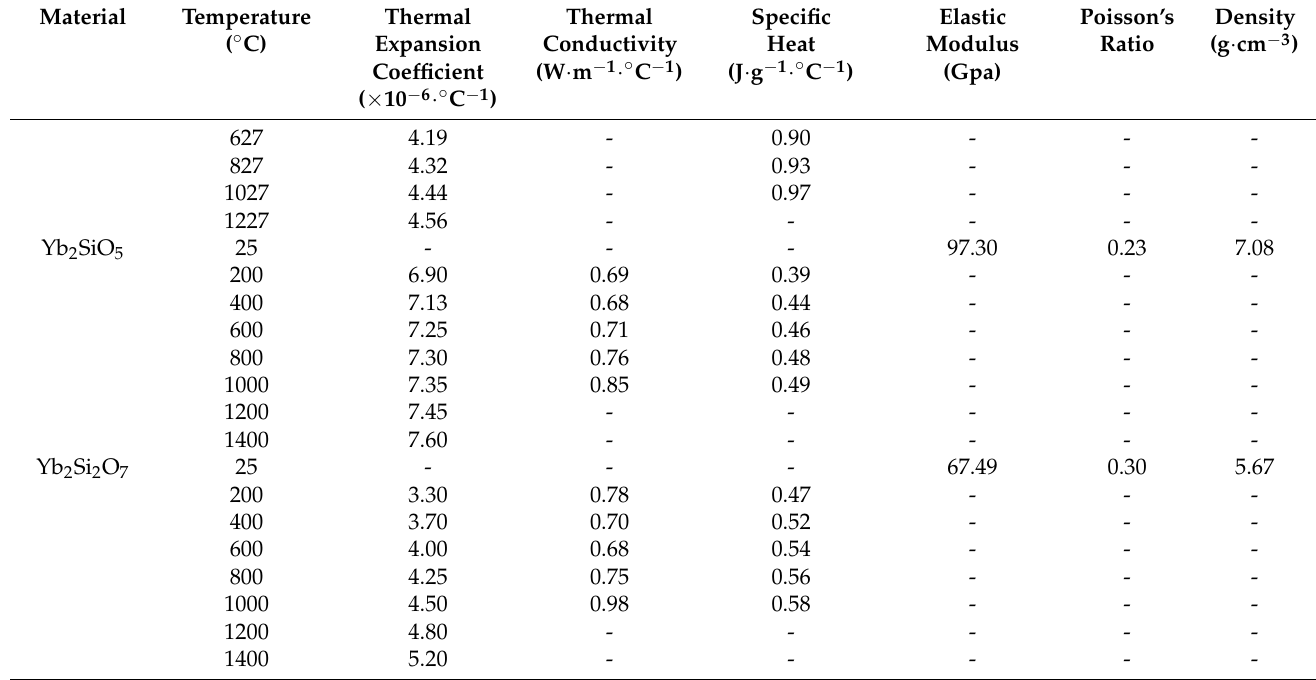
Table A1. Thermophysical parameters of substrate and EBCs.